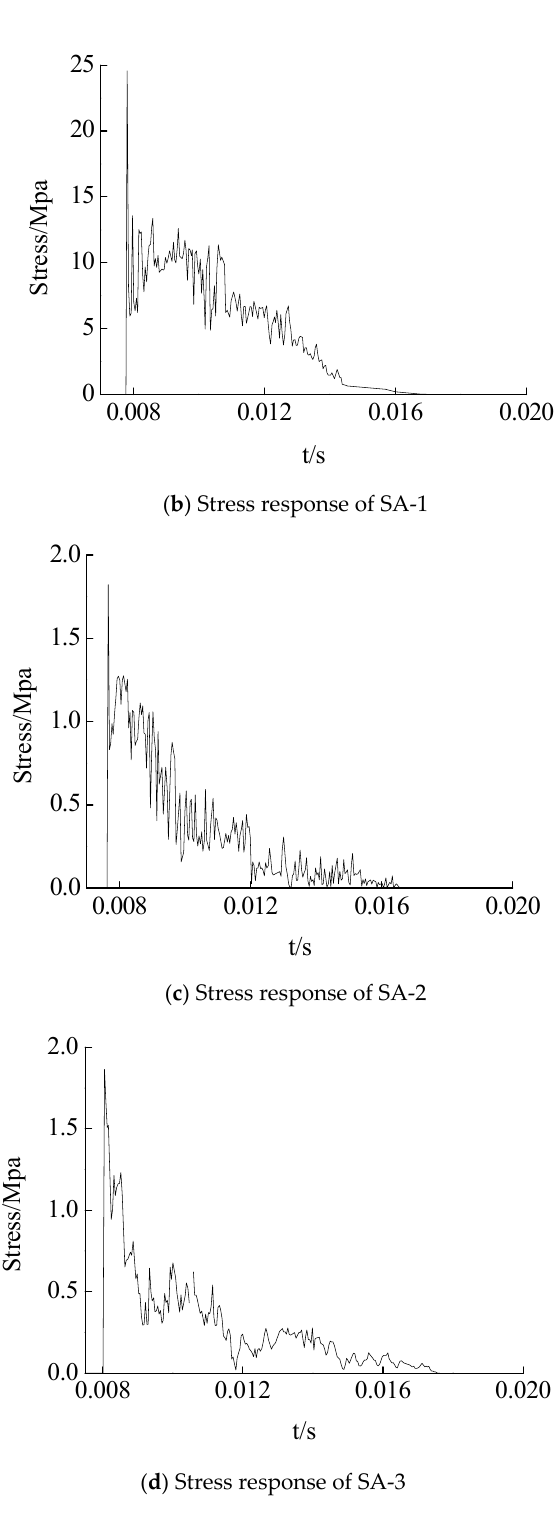
Figure 14. Smart aggregate responses.